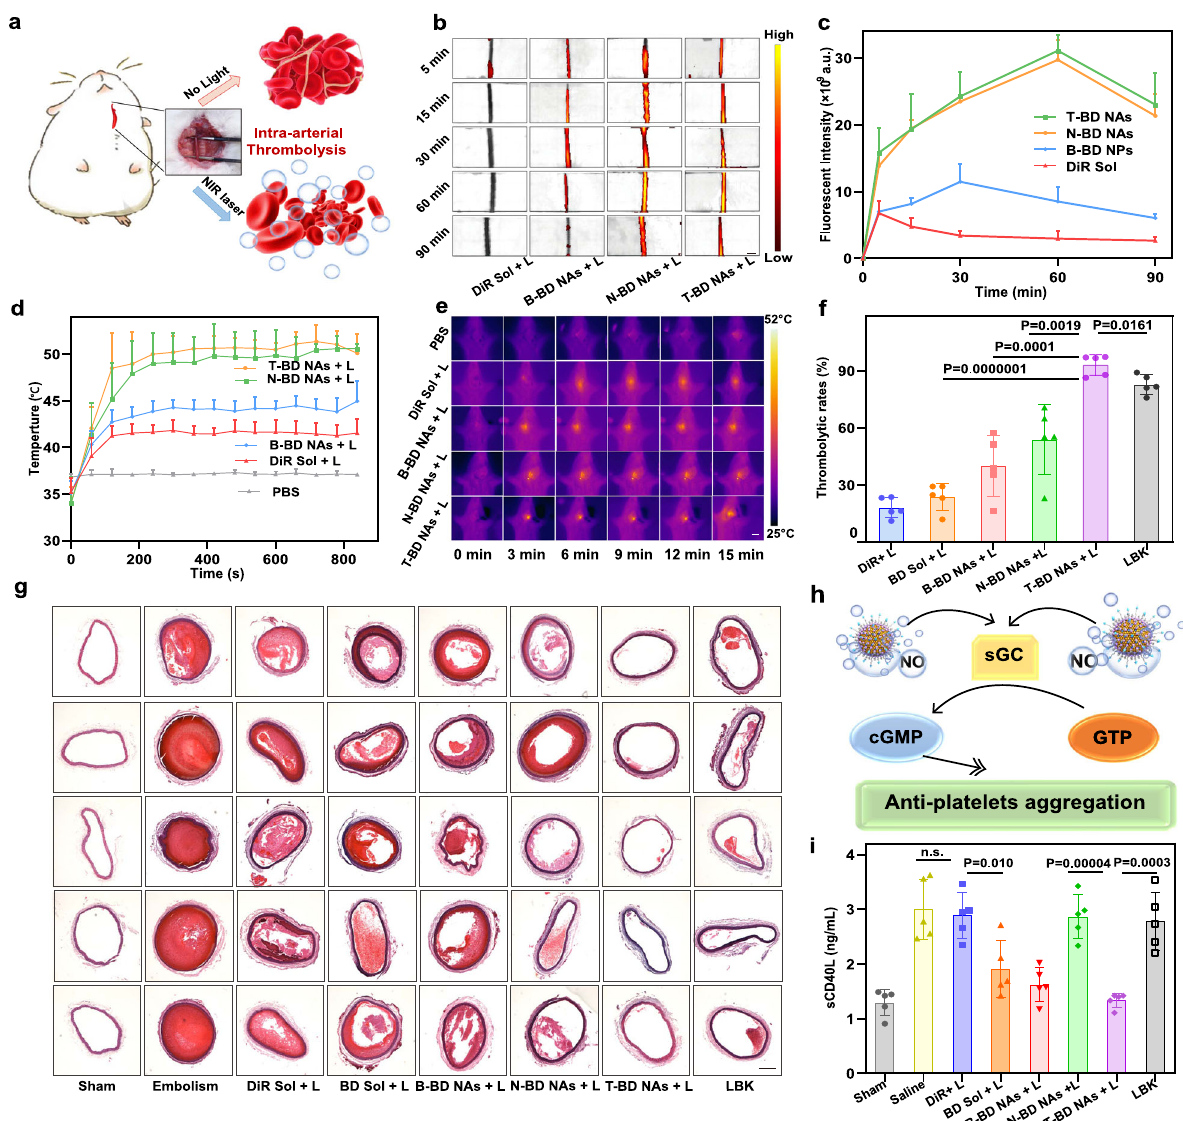
Fig. 5 | Intra-arterial thrombolysis in SD rats ( n =5). a Schematic representation